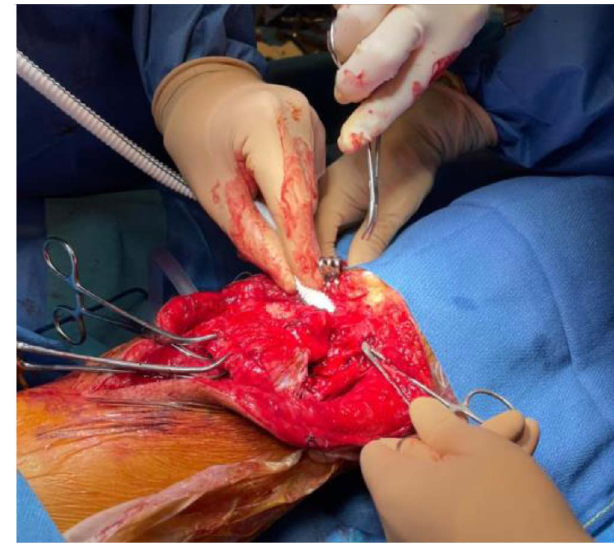
Figure 10. A Kocher clamp is used to pass one leg of the bifurcation through the 7 mm tunnel.